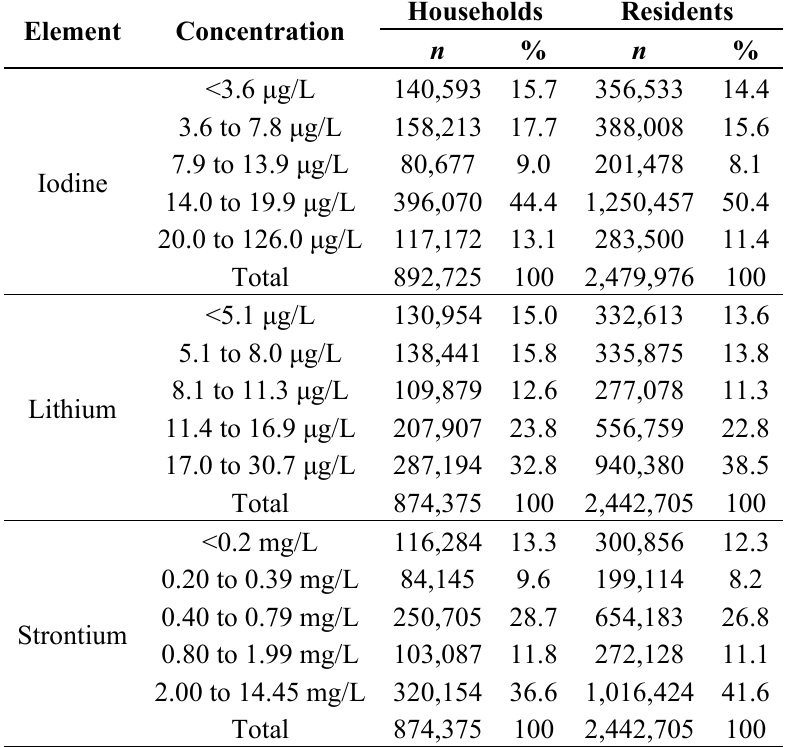
Figure 4. Proportion of households and residents exposed to different concentrations of ( a ) iodine, ( b ) lithium, and ( c ) strontium. Note: the number of households and number of residents are estimated using two different datasets (see Section 2); see Table 3 for absolute numbers. Table 3. Households and residents exposed to different concentrations of iodine, lithium, and strontium in absolute numbers ( n ) and in percentages (%; see also Figure 4). Element Concentration